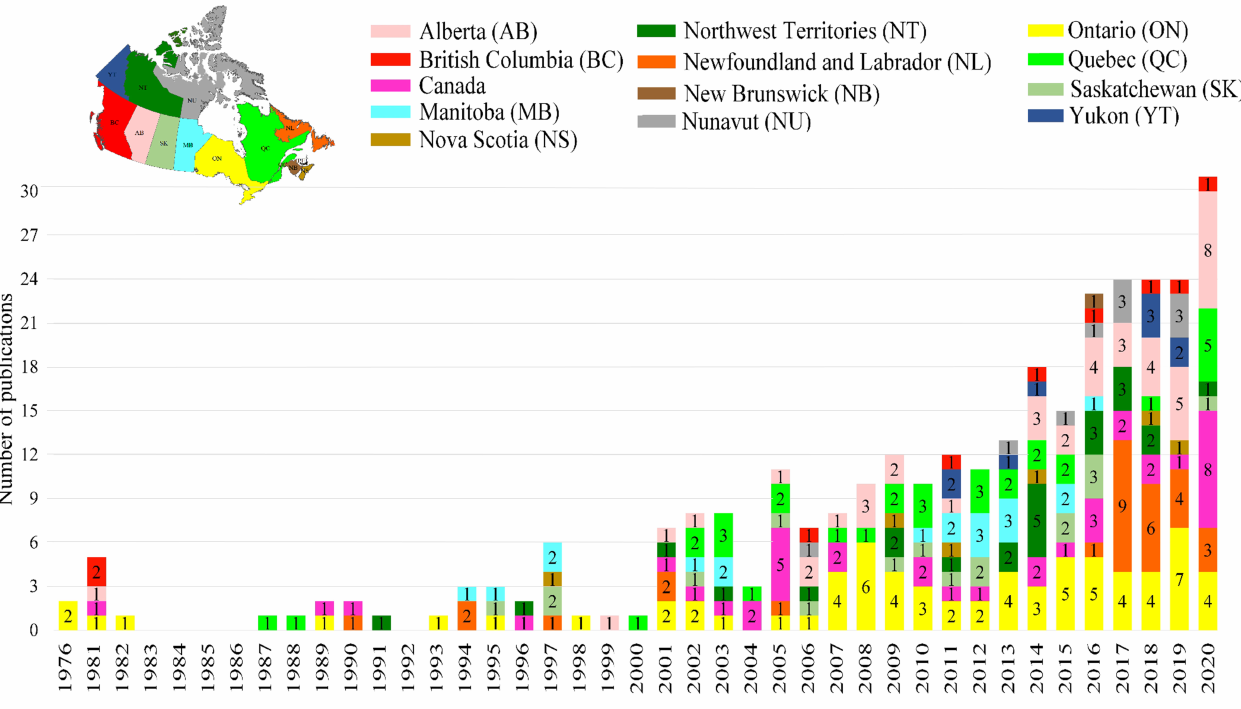
Figure 4. The number of publications on RS-based wetlands studies in Canada for each year (since 1976) according to the study area (i.e., Canadian